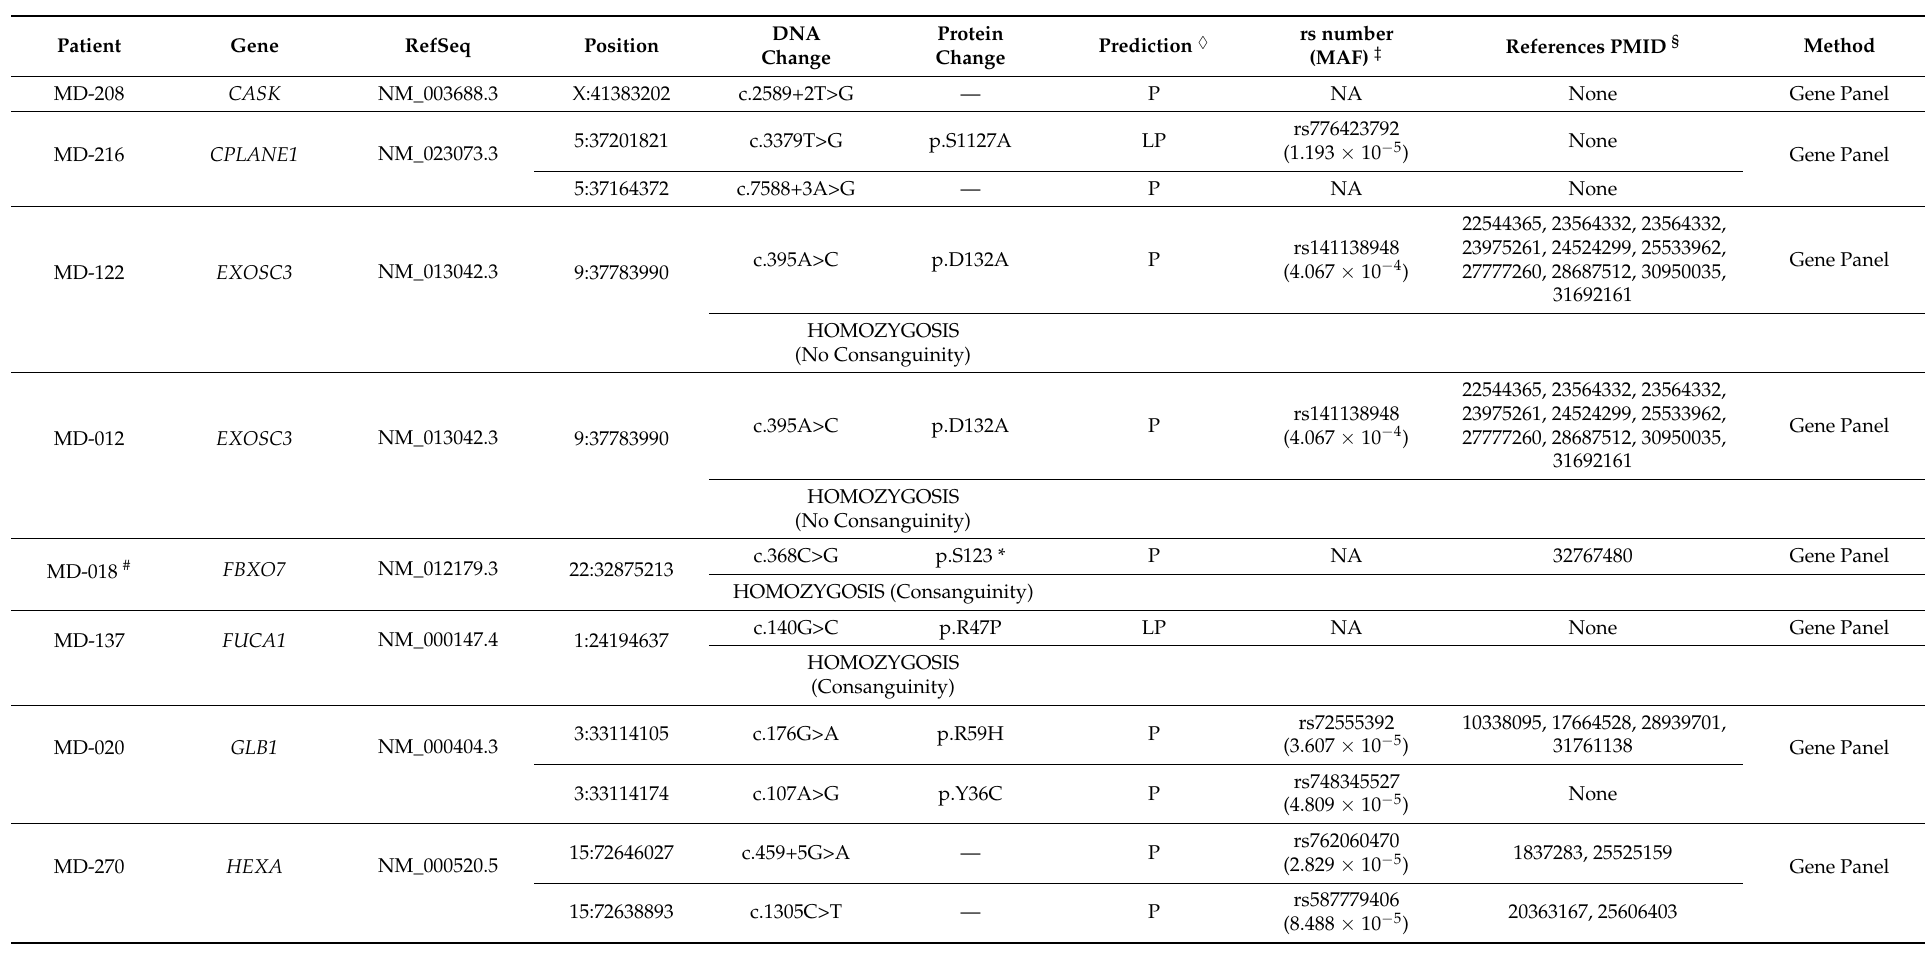
Table 1. Genetic findings of the 29 solved